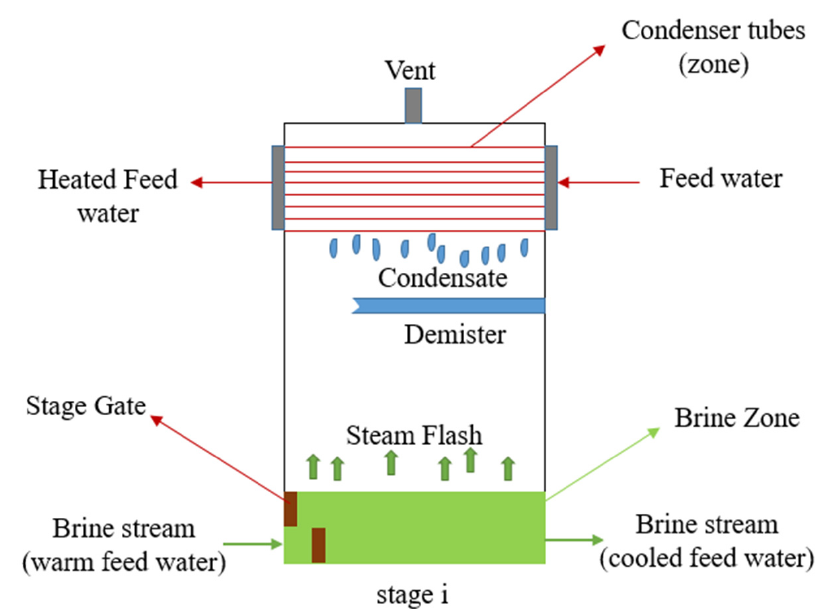
Figure 5. MSF desalination stage.